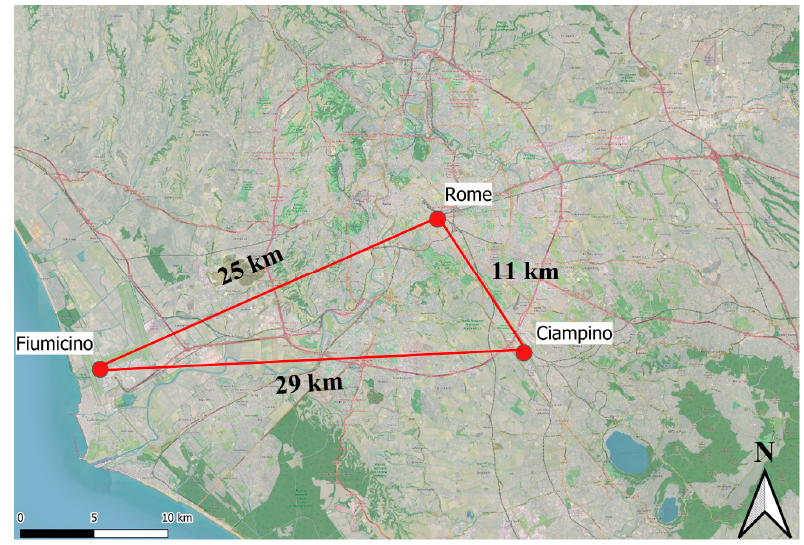
Figure 1. Locations of the weather stations.